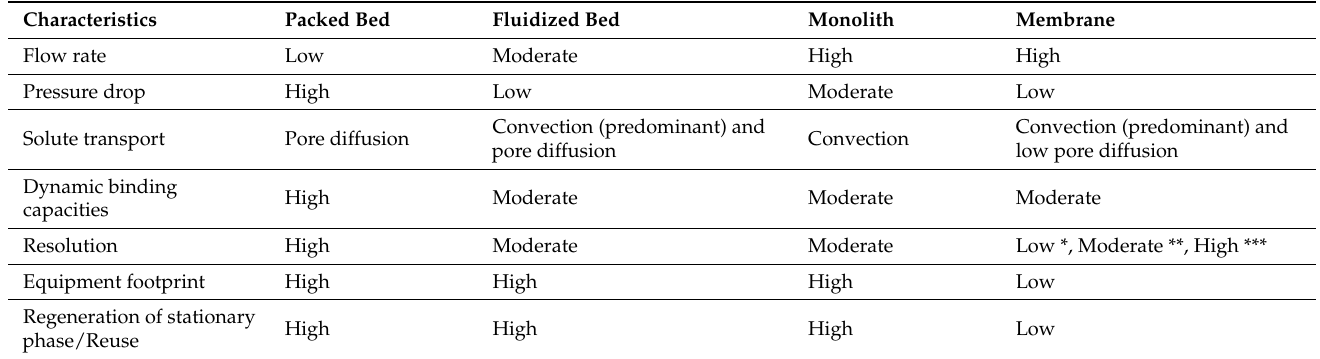
Table 1. Comparison of different stationary phases in chromatographic system (Self-developed, concept was adopted from Ghosh, 2002 [41], Ghosh and Wong, 2006 [57], Ghosh et al., 2020